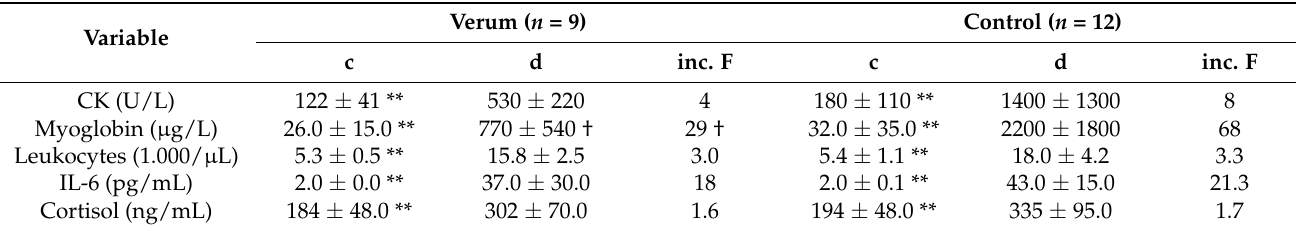
Table 3. Exercise-induced stress values of the 21 participants who completed both the intervention and the marathon race before (time point c) and after the race (time point d).